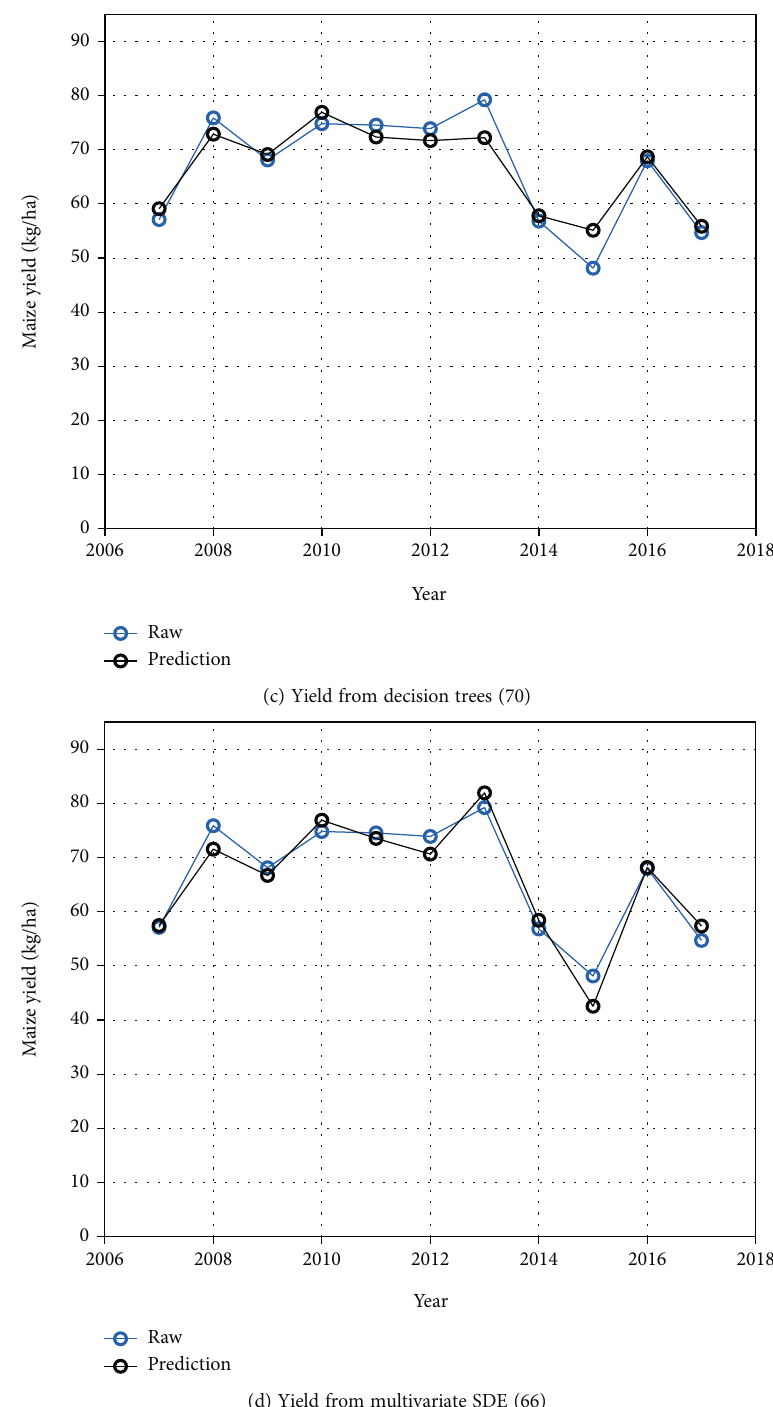
Figure 15: Maize yield prediction from the joint stochastic process up to R 2 = 0 : 9765 and MAPE = 1 : 94 %